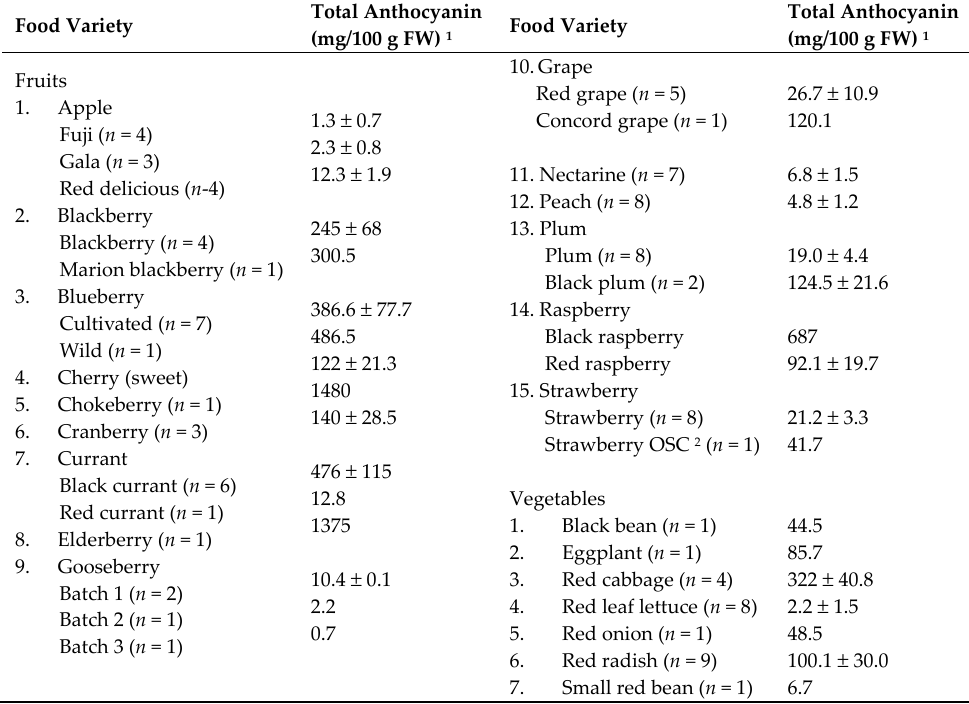
Table 1. Total content of anthocyanins in common fruits and vegetables in the United States (adapted with permission from reference [6]).